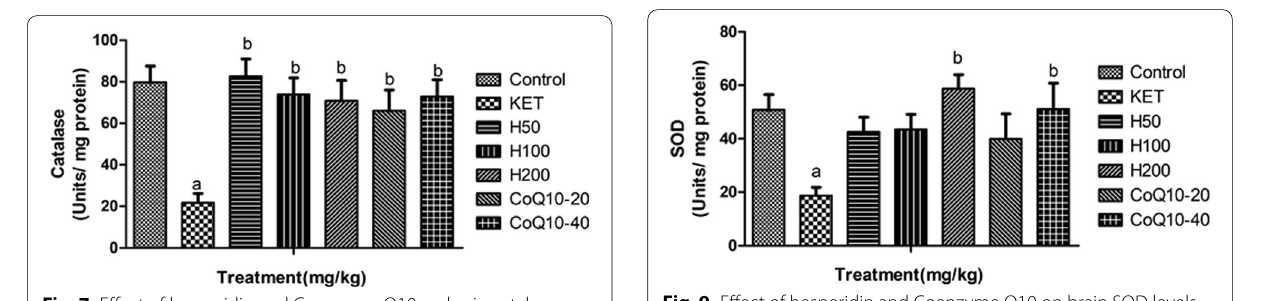
Fig. 7 Effect of hesperidin and Coenzyme Q10 on brain catalase levels in the prefrontal cortex region of the brain. Data were analyzed by one-way ANOVA followed by Tukey’s post hoc analysis. All values were expressed as Mean SEM. a p < 0.05 as compared to naive, ± b p < 0.05 as compared to ketamine. KET, Ketamine; H, Hesperidin; CoQ10, Coenzyme Q10